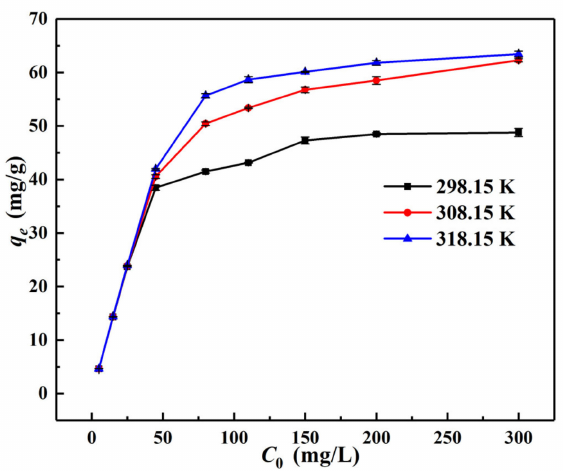
Figure 9. Influence of initial concentration on Cr(VI) adsorption by α –FeO(OH)/GOCS.